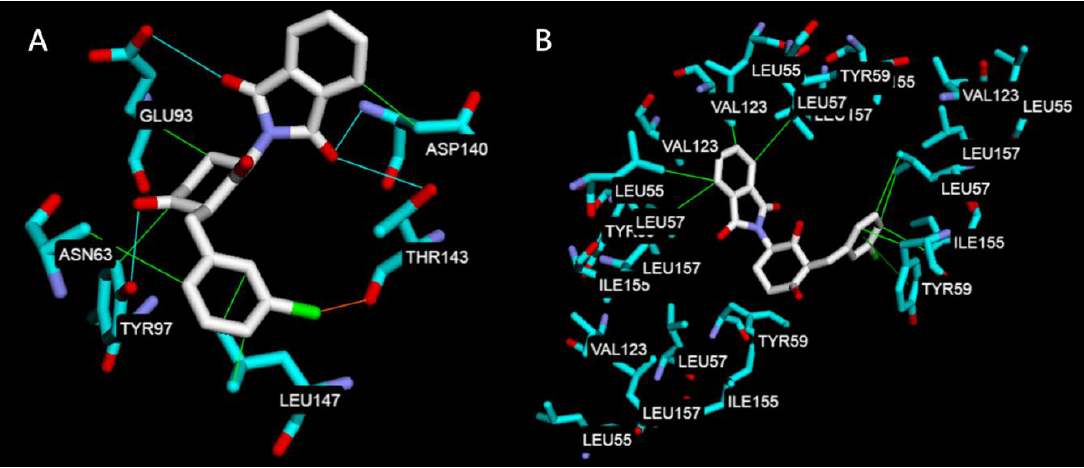
Figure 7. Docking poses of compound 5c at the ( A ) IL-6 (PDB code 1ALU) and ( B ) TNF- α (PDB code 2AZ5). The interaction illustrated by green lines represents hydrophobic interaction, blue lines represent hydrogen bonding, and orange line represents halogen bonding.